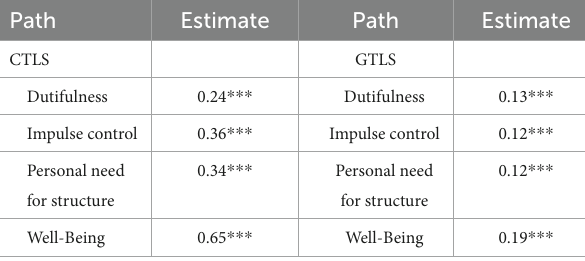
TABLE 5 SEM for criterion validity test ( N =